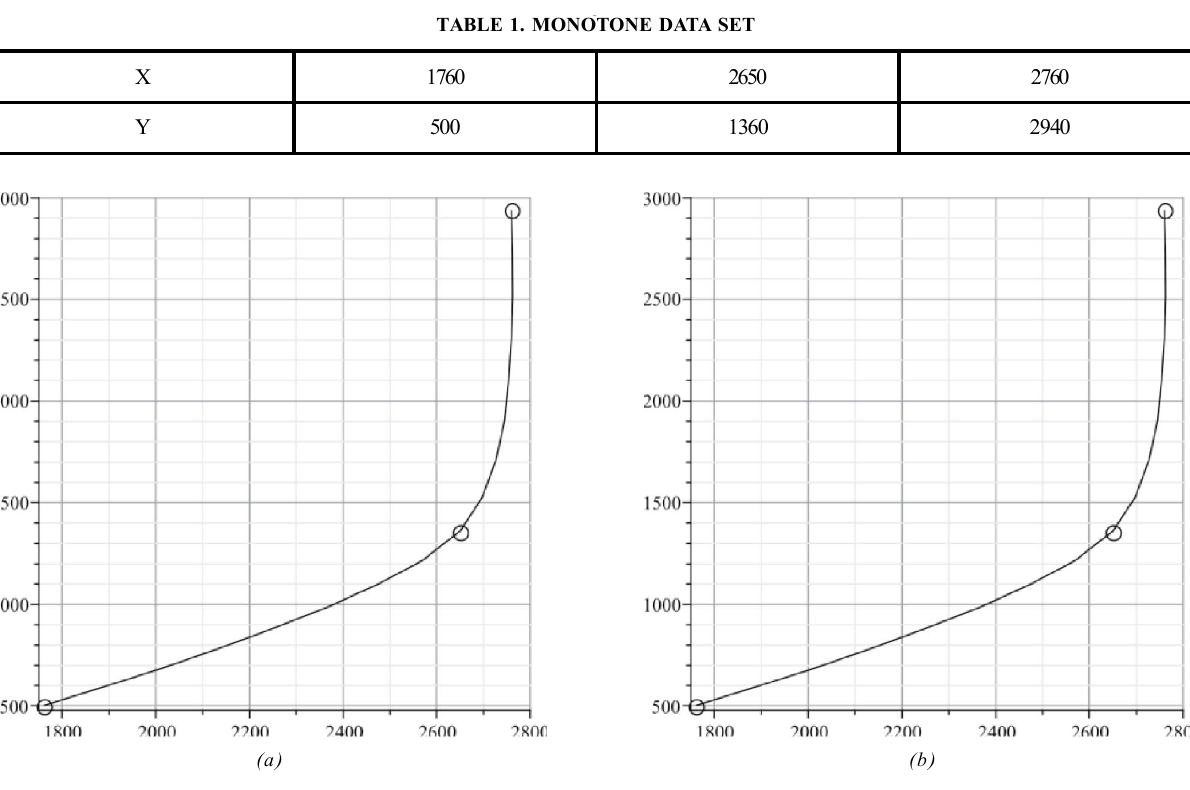
FIG. 2. THE CURVES (a) AND (b) ARE PRODUCED BY THE SCHEMES (5) AND (6), RESPECTIVELY, BY USING MONOTONE DATA SET